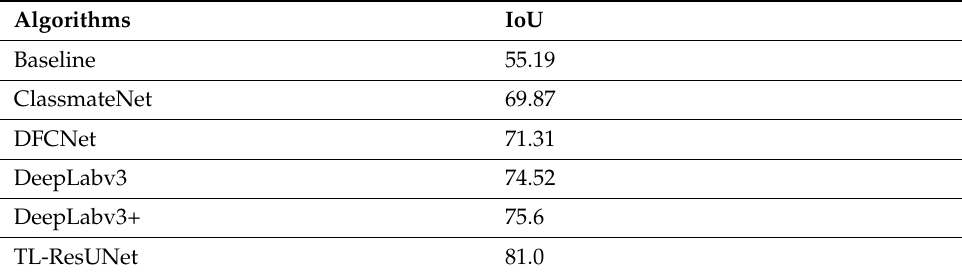
Table 4. Comparison of the TL-ResUNet with other